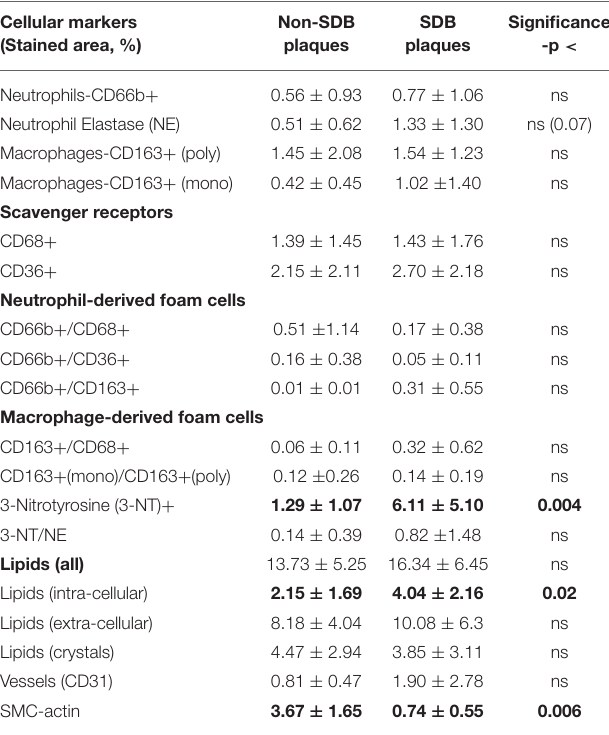
TABLE 2 | Quantitative analysis of cellular plaque markers (by % stained area ± SD) in patients without and with SDB. Cellular markers (Stained area, %)